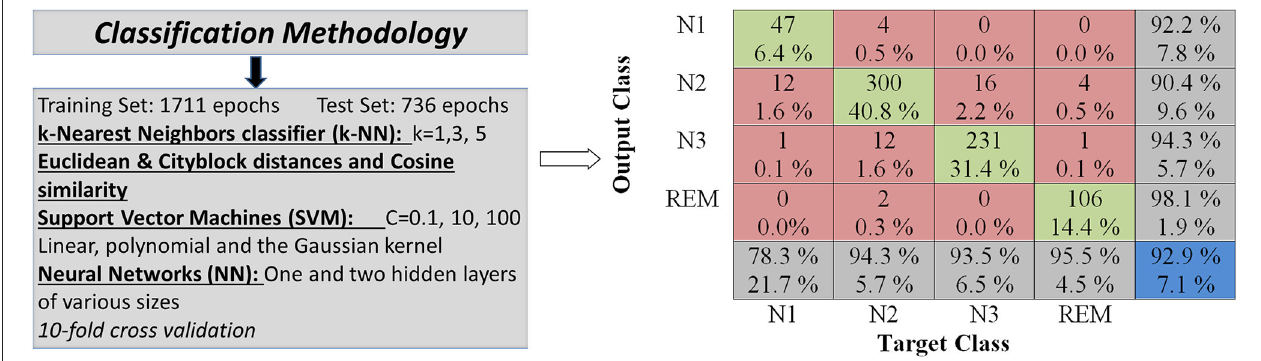
FIGURE 3 | Computer-assisted classification is performed with various classifiers such as the k-Nearest Neighbors (kNN), Support Vector Machines (SVMs) and Neural Networks (NNs). Various classification parameters are employed in a comparative analysis.